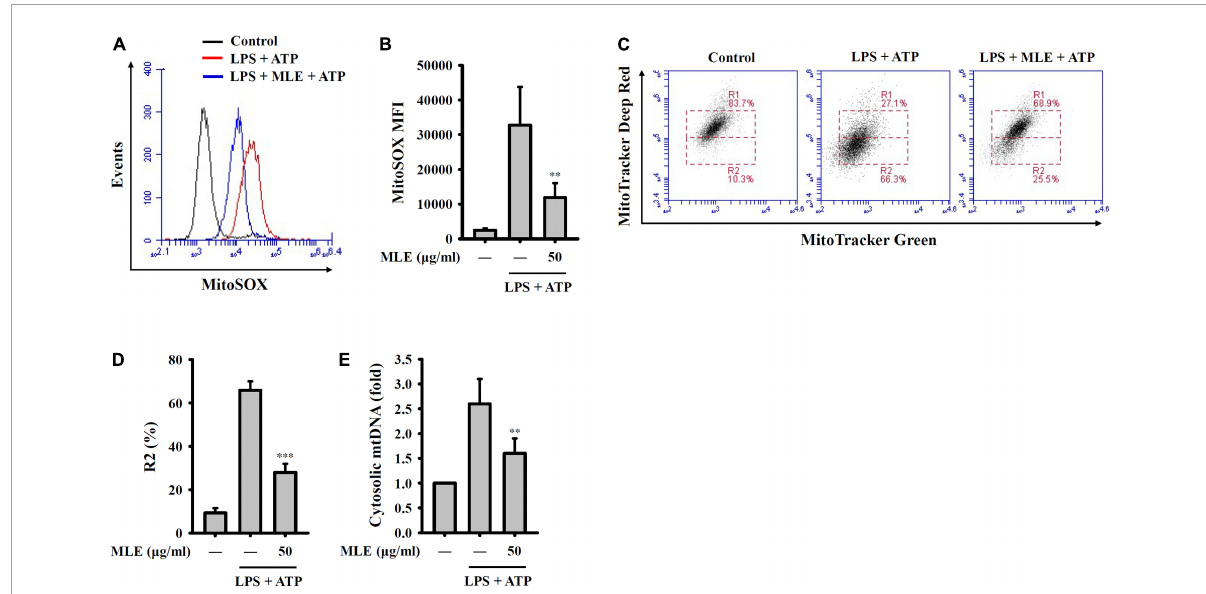
FIGURE4 MLE inhibited activation signals of the NLRP3 inflammasome by reducing mitochondrial damage. (A–E) LPS-primed J774A.1 macrophages were incubated with MEL for 0.5 h before ATP stimulation for an additional 0.5 h. (A) Mitochondrial ROS production was analyzed by MitoSOX staining using flow cytometry. (B) The column diagram represents the mean fluorescence intensity of MitoSOX in (A) . (C) Mitochondrial membrane integrity was analyzed by MitoTracker Deep Red and Green staining using flow cytometry. (D) The column diagram represents the% of low MitoTracker Deep Red signal (R2) in (C) . (E) Mitochondrial DNA release into the cytosol was analyzed by the detection of cytochrome c oxidase I DNA in the cytosol. The data are expressed as the mean ± SD of three separate experiments. ** p < 0.01 and *** p < 0.001 compared to the LPS + ATP